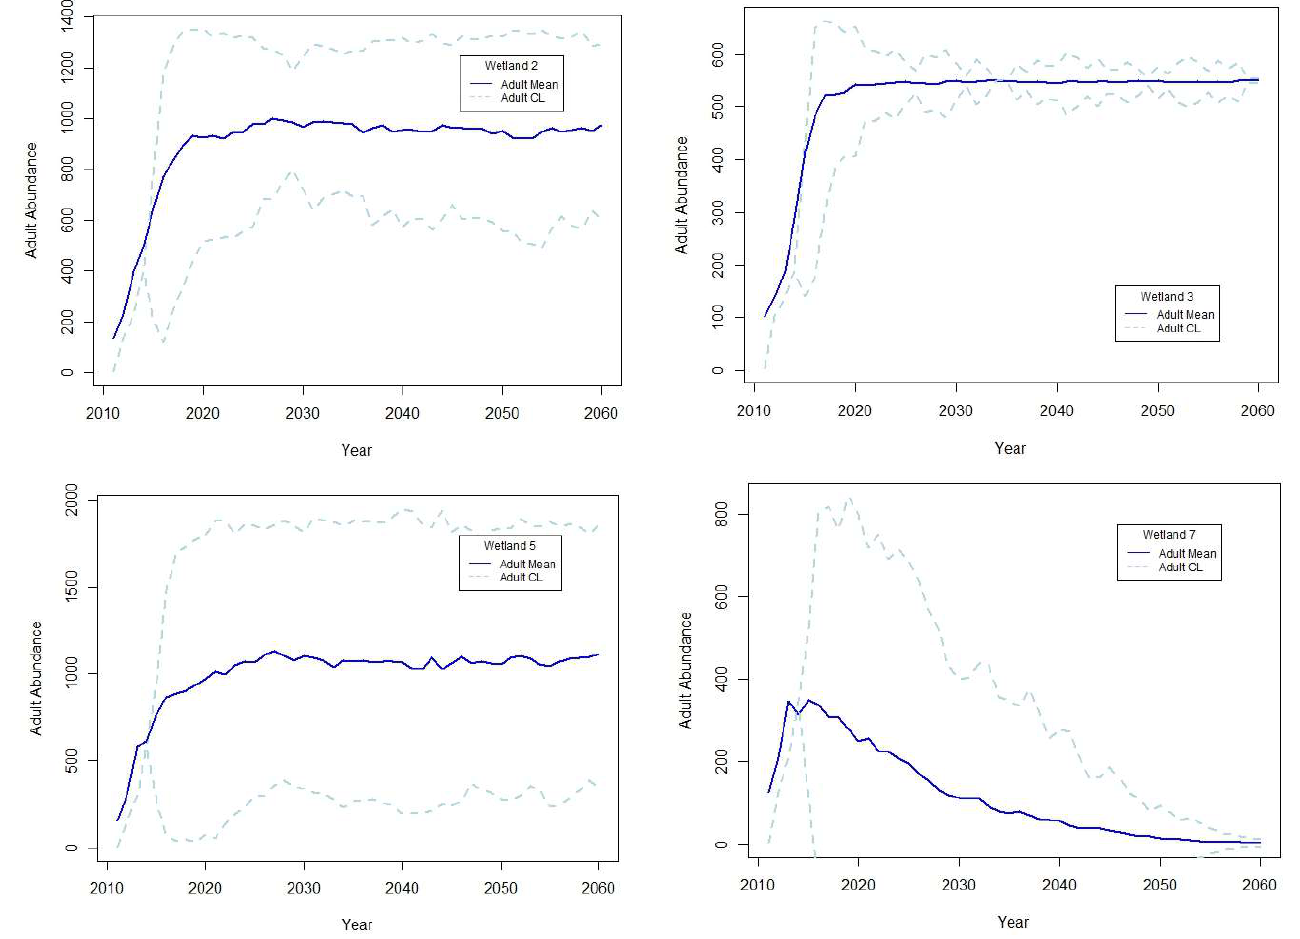
Figure 3. Mean and confidence limits (CL) for 100 simulated projections of estimated relative adult abundance for four patterns of hydroregimes using the same probabilities of OHY, MHY, and IHY as those predicted for wetlands 2, 3, 5, and 7 using the CSIRO Mk3.5 GCM climate projections but in no specified sequence. Probabilistic projections included the same standardized representative assumptions of density-dependent population limitation, with emphasis on environmental stochasticity effects rather than precise population estimates.